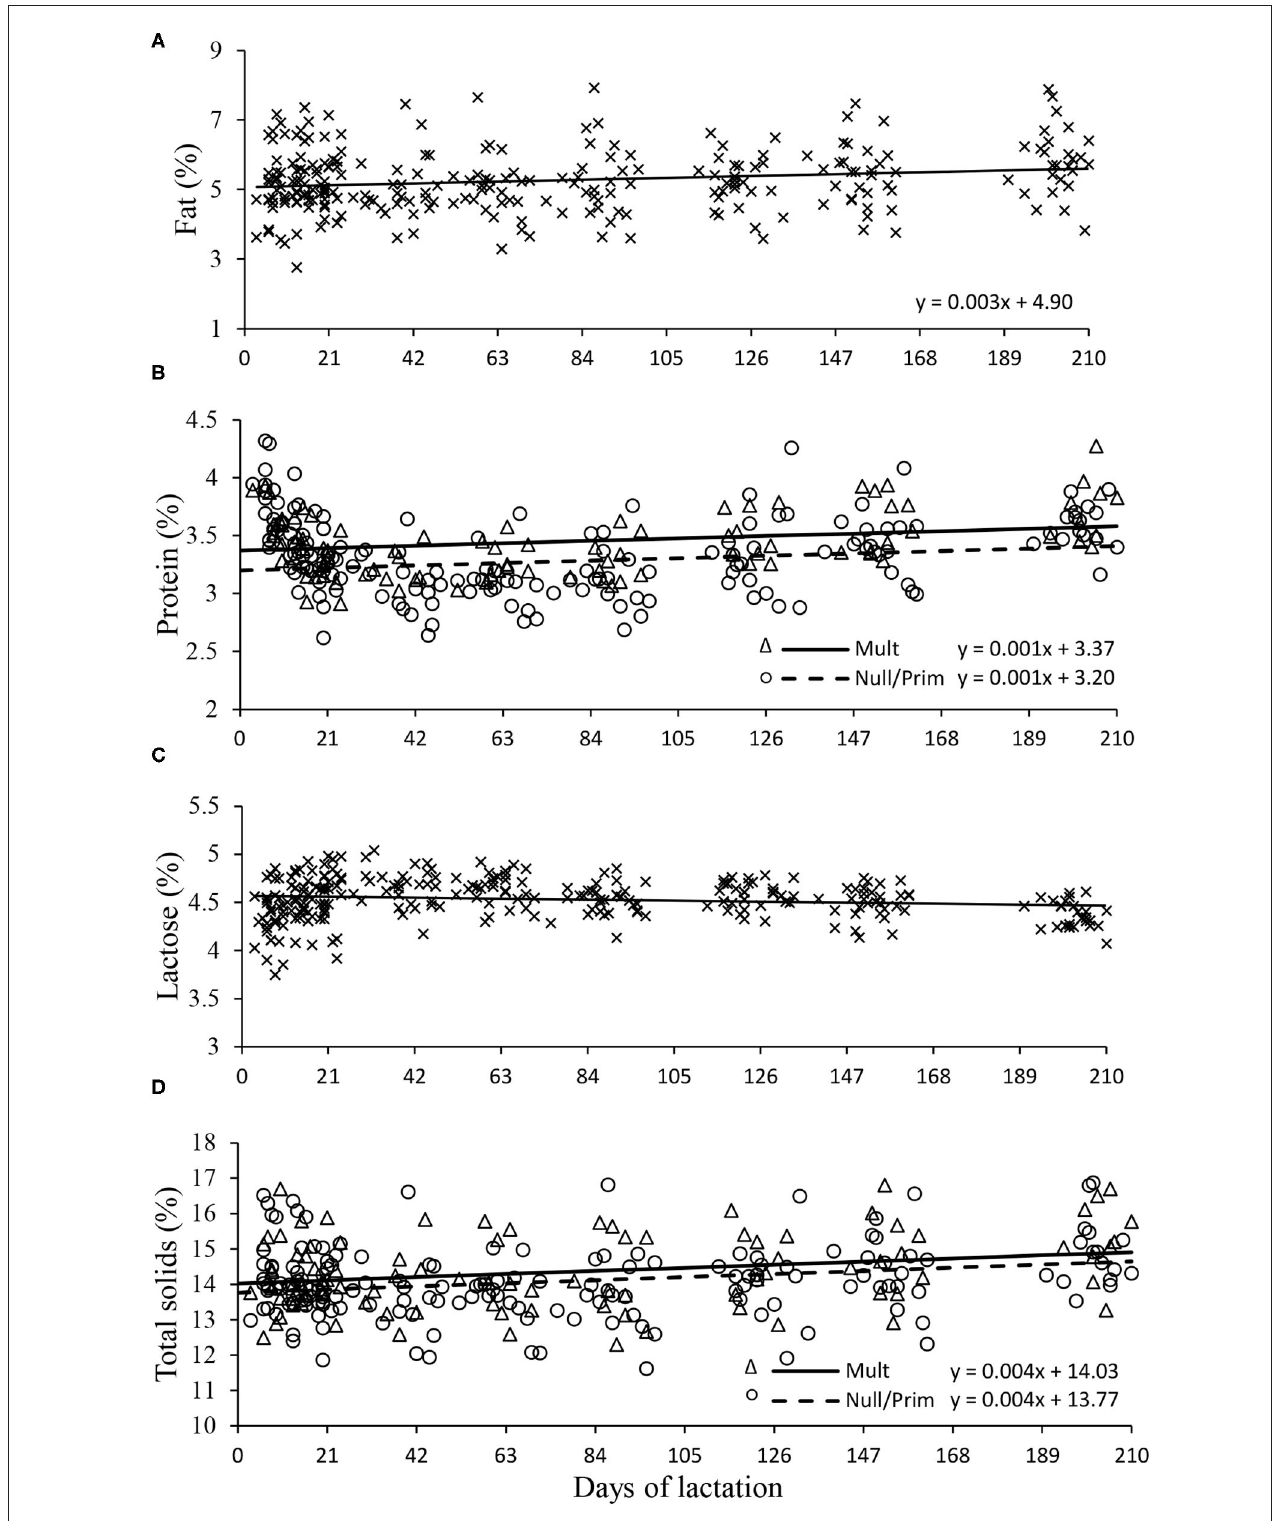
FIGURE 2 | Milk fat (A) , protein (B) , lactose (C) , and total solids (D) of Nellore cows according to parity order under grazing. Mult (multiparous), Prim (primiparous), and Null (nulliparous).